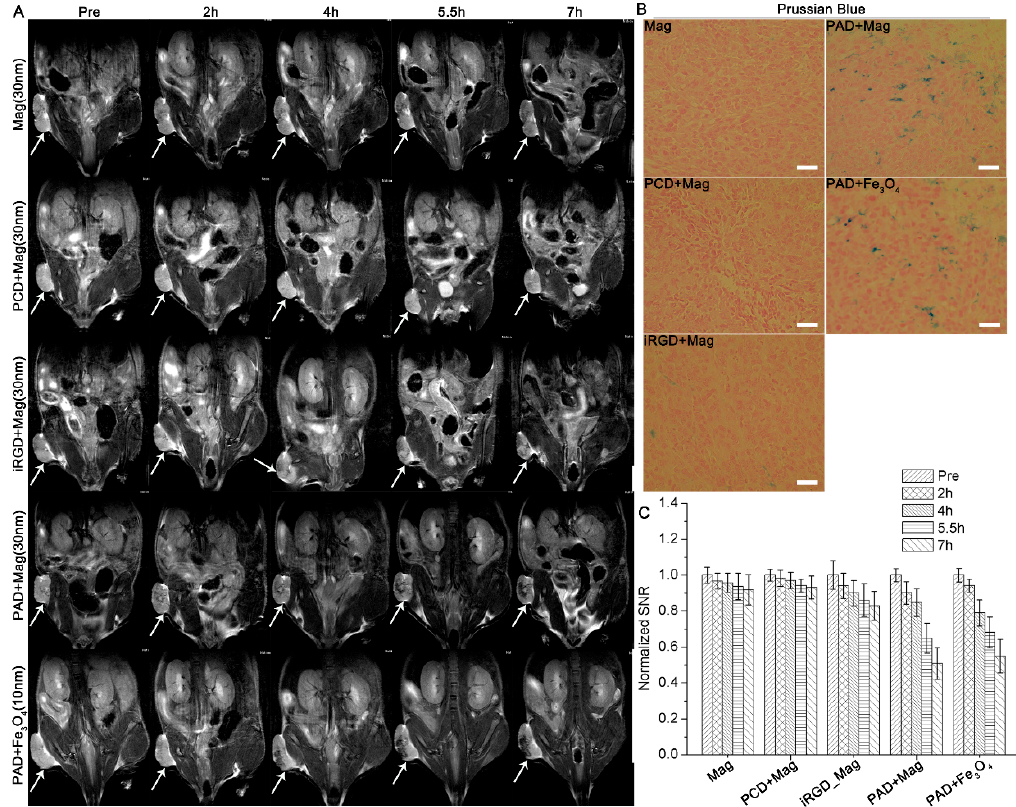
Figure 2. T 2 -weighted MRI imaging of BALB / c nude mice bearing PC-3 xenograft tumors before and after the injections. ( A ) MRI images of the mice before and after injected with Mag, PCD + Mag, iRGD + Mag, PAD + Mag, and PAD + Fe 3 O 4 (10 nm) at 2 h, 4 h, 5.5 h, and 7 h. The white arrows indicate xenograft tumors; ( B ) Prussian blue staining of tumor slices from the mice 7 h after the injection (scale bars: 25 µ m); ( C ) the normalized signal-to-noise ratio (SNR) ratios of T 2 signal for the tumors in each group at di ff erent time